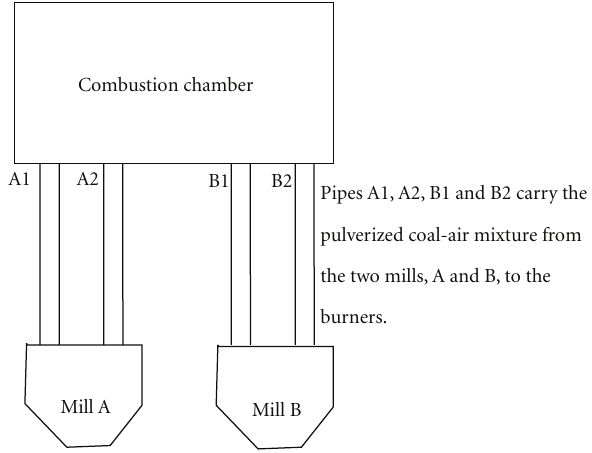
Figure 1: Mill (pulverizer) and combustion chamber layout (after